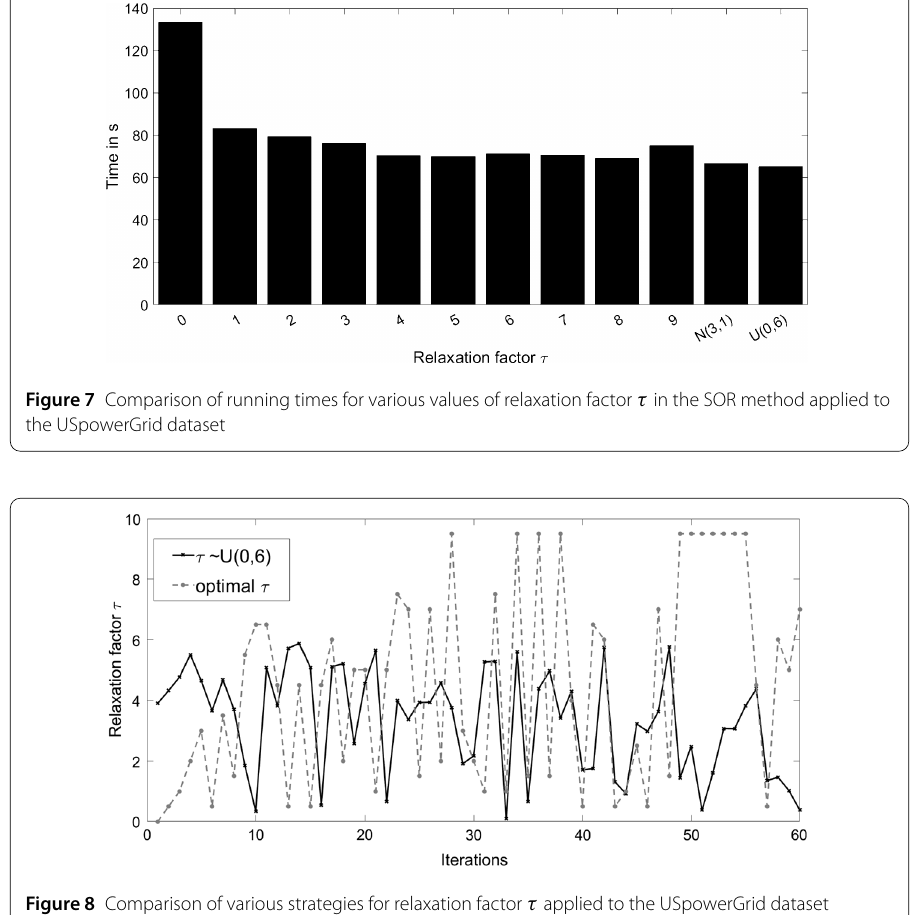
Figure 8 Comparison of various strategies for relaxation factor τ applied to the USpowerGrid